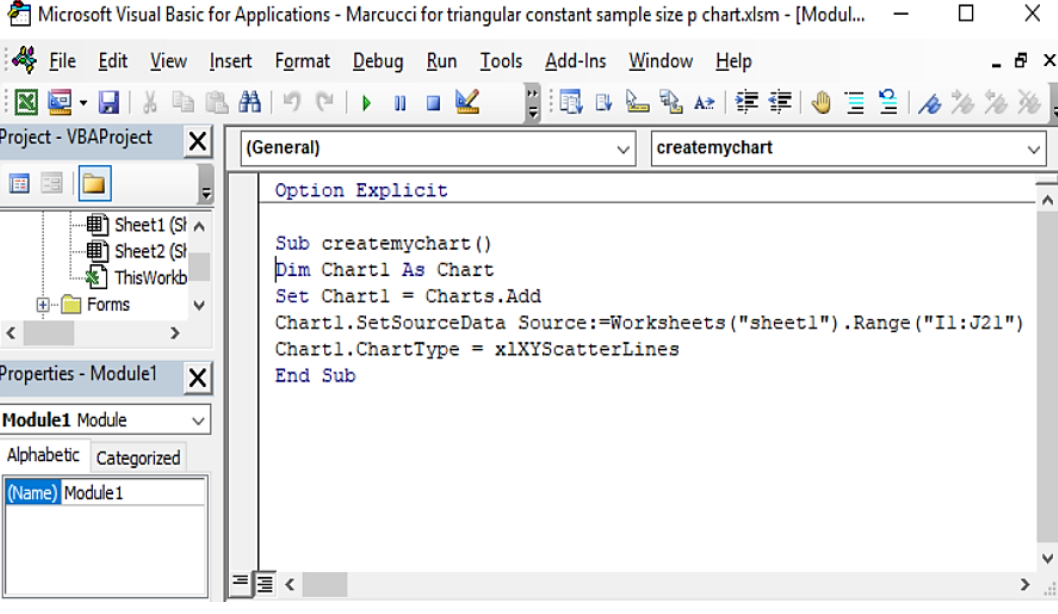
Figure 10. Visual Basic Coding for Creating P-Chart Automatically.